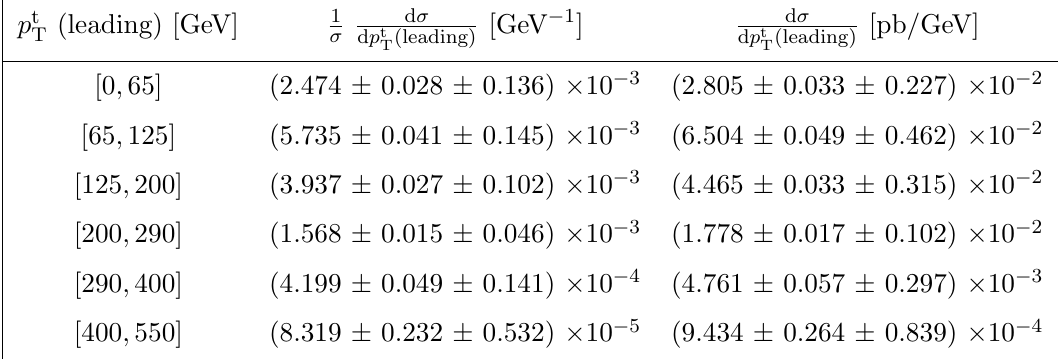
Table 17 . The measured di(cid:11)erential cross section and bin boundaries for each bin of the normalized and absolute measurements of the tt di(cid:11)erential cross section at particle level in the (cid:12)ducial phase space as a function of p t (leading) are tabulated. T